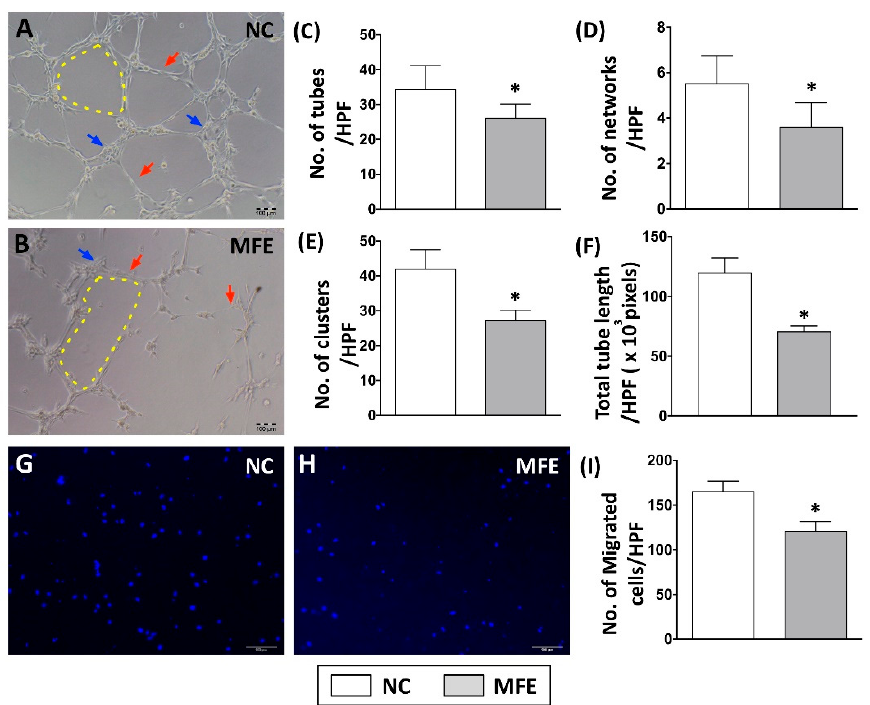
Figure 1. Maternal fructose exposure impaired angiogenic activity of bone marrow-derived endothelial progenitor cells. ( A , B ) In vivo angiogenic activity analysis (matrigel) on bone marrow-derived endothelial progenitor cells (BMDEPC) of 3-month-old offspring. ( C ) Calculation of tube formation in matrigel (red arrows). ( D ) Calculation of network formation in matrigel (yellow dotted line). ( E ) Calculation of cluster formation in matrigel (blue arrows). ( F ) Calculated of accumulated tube length. ( G , H ) Trans-well analysis to determine the migratory activity of BMDEPC. ( I ) Calculation of migrated cells in the trans-well assay. Results showed that the numbers of tube, network, and clusters in the MFE group were significantly lower than those in the NC group. NC, maternal control; MFE, fructose exposure. Scale bar in the lower-right corner indicates 100 μ m. Error bars represent the standard deviation (SD). * Indicates statistical significance between NC and MFE group. n = 8 for each group.